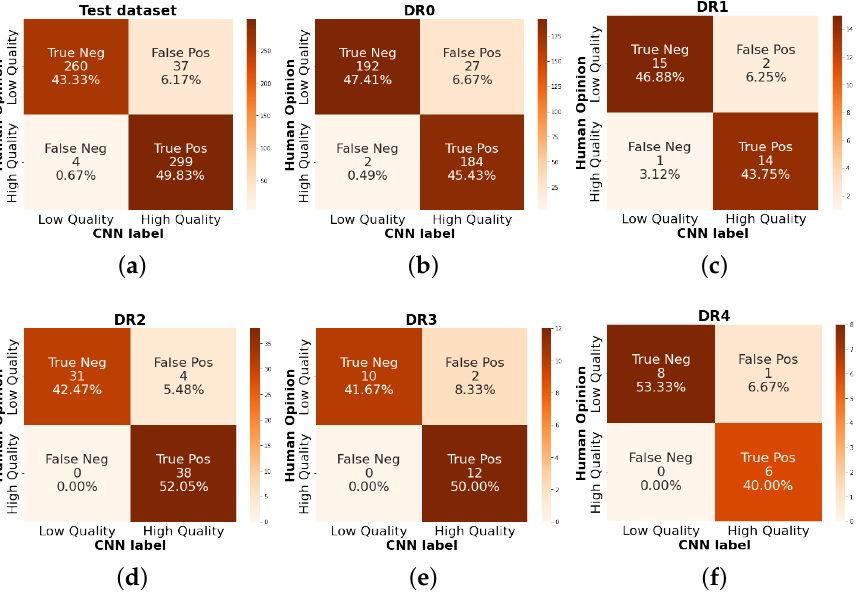
Figure 14. Quality rating confusion matrix separated by DR grading. ( a ) It is the total of the test dataset 600 items, ( b ) 405 RFIs with DR grade 0, ( c ) 32 with DR1, ( d ) 73 items for DR2, ( e ) DR grade with 24 images and ( f ) 15 for proliferative